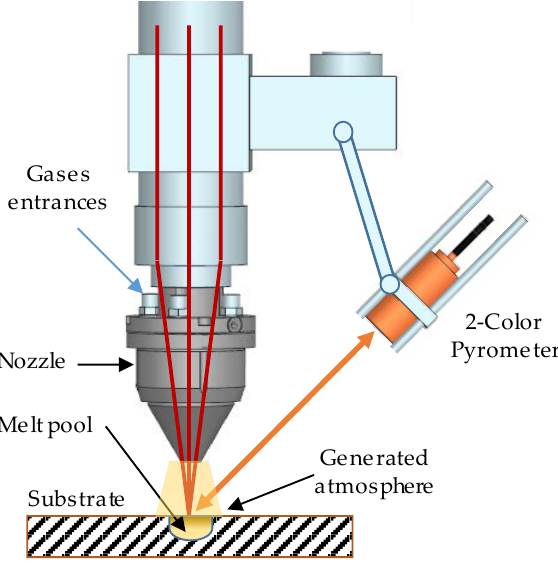
Figure 1. Experimental setup.